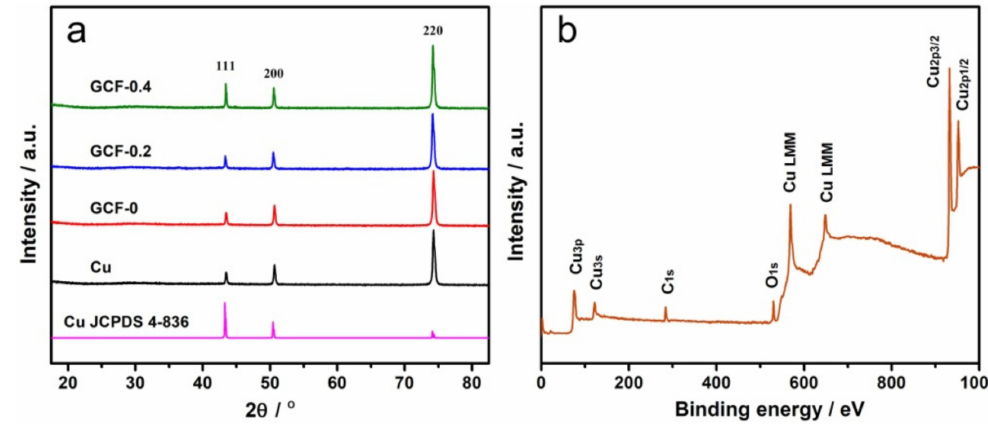
Figure 2. XRD patterns of the samples ( a ) and XPS spectra of sample GCF-0.2 ( b ).